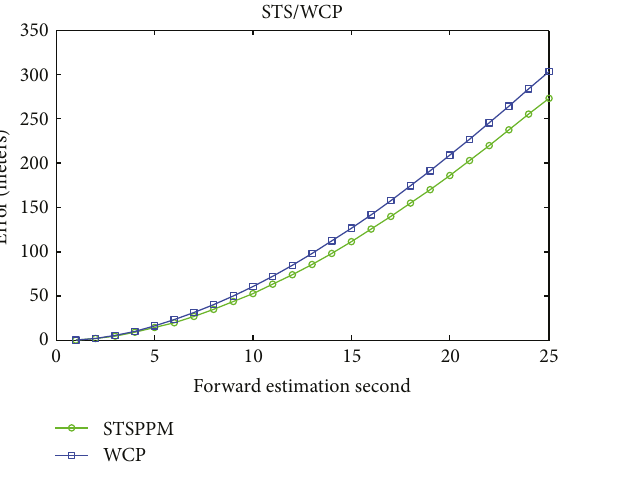
Figure 10: STS versus WCP prediction errors.